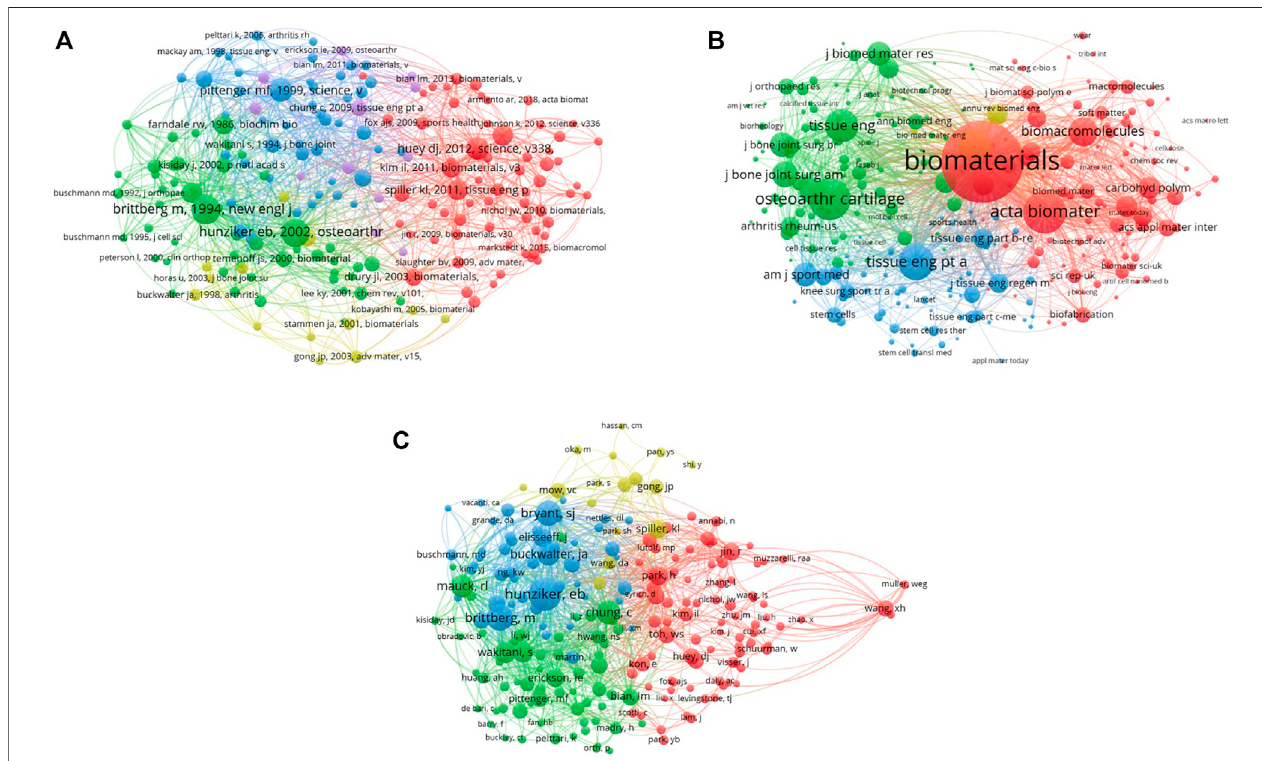
Figure 8 | Co-citation analysis of researches about hydrogel in cartilage repair. (A) Map of co-cited reference related to researches about hydrogel in cartilage repair. (B) Map ofco-cited journals related toresearches about hydrogel incartilage repair. (C) map ofco-citedauthors related toresearchesabout hydrogel in cartilage repair.Thecitationfrequencyisrepresented bythe sizeofthedotsand thelinebetweentworepresentsthatthetwowerecited inasamepaper/journal. Shorter theline, stringer the link between two dots.